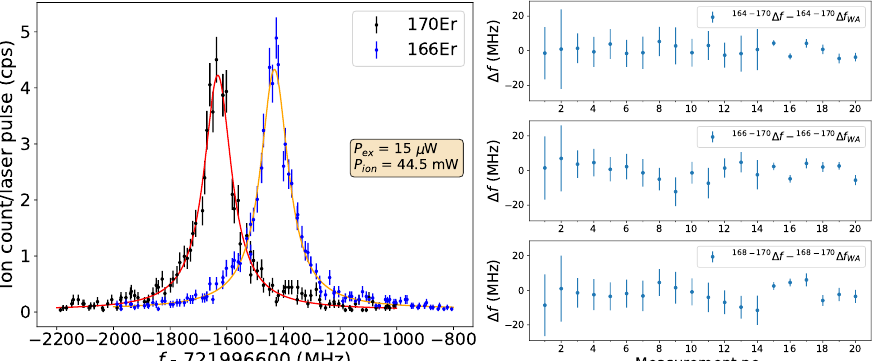
Figure 9. ( Left ) Normalized IS measurements of 166 − 170 Er I (red/orange curve—SATLAS [35] χ 2 fit of the data; f 0 = 721.9966 THz; excitation and ionization step powers are represented in the text box). ( Right ) Scattering of individual IS ( ∆ f ) measurements around the weighted average IS ( ∆ f WA ) from all NB RIS measurements. The used RIS scheme is presented in Figure